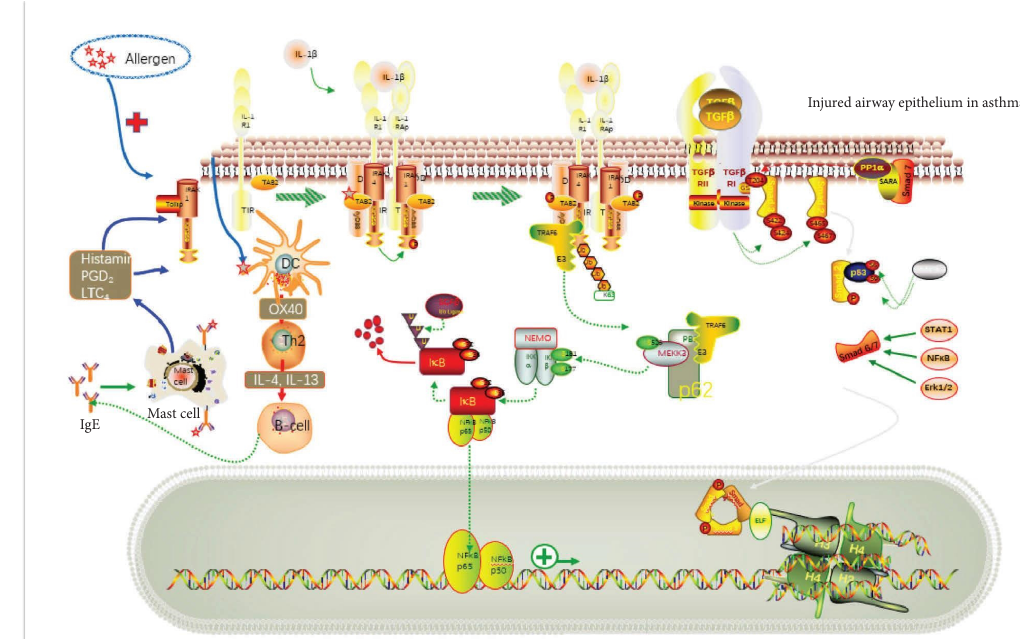
Figure 1: Molecular pathological mechanisms of